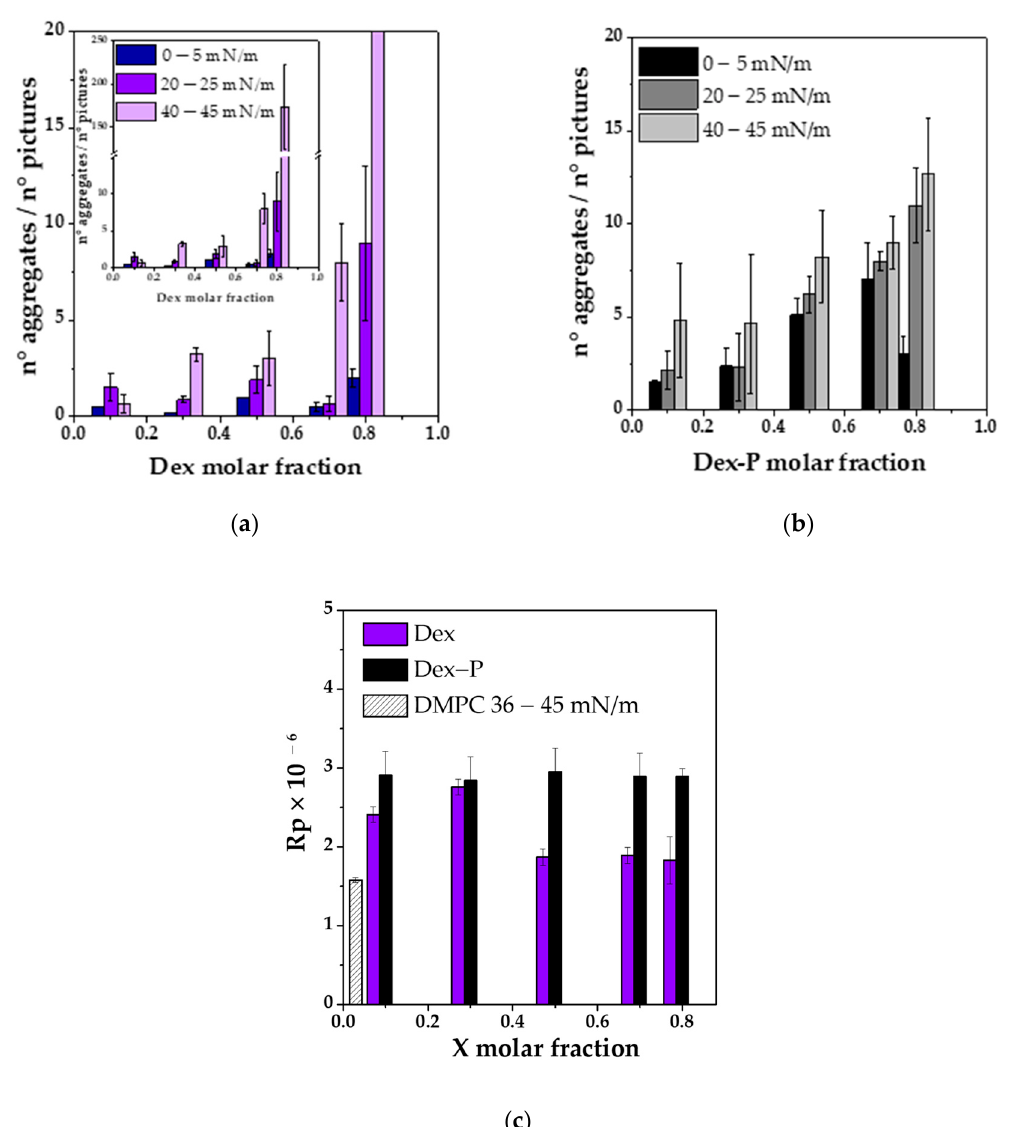
Figure 5. Average number of aggregates as function of the drug molar fraction, for DMPC:X, X: ( a ) Dex and ( b ) Dex-P, in the pressure range of 0–5 mN/m, 20–25 mN/m and 40–45 mN/m. ( c ) Reflectivity of the most probable population of aggregates as function of the molar fraction. In the case of DMPC correspond to the LC phase. The values were obtained from BAM images such as those shown in Figure 3a,b, average from two independent experiments.